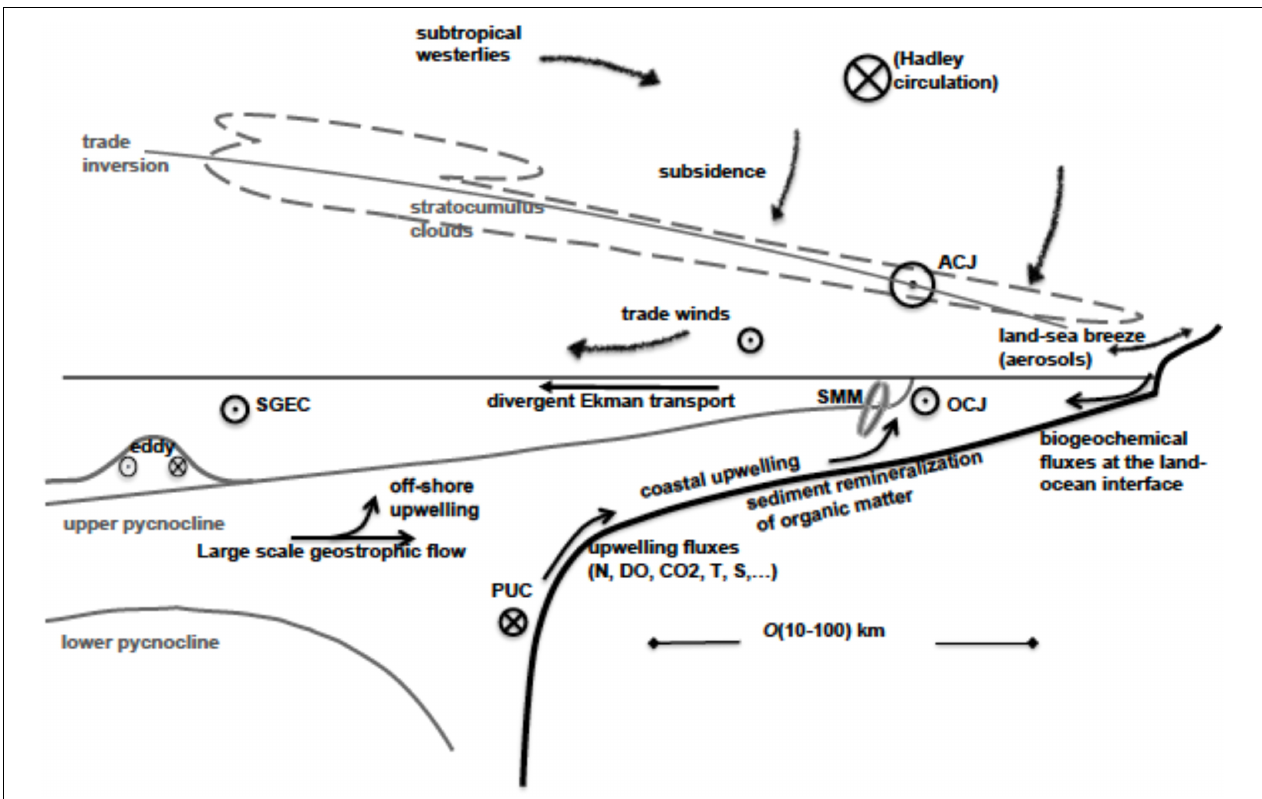
FIGURE 4 | Schematic of processes at play in Eastern boundary upwelling system (direction of flow corresponds to the northern hemisphere). Arrows represent mass or quantity fluxes. SMM: submesoscale mixing. SGEC, subtropical gyre equatorial current; EBC, Eastern boundary current; PUC, poleward undercurrent; ACJ, atmospheric coastal jet; OCJ, oceanic coastal jet; Gray lines, isopycnals and clouds (dashed). Modified from the one generated at the first EBUS meeting in Ankara in